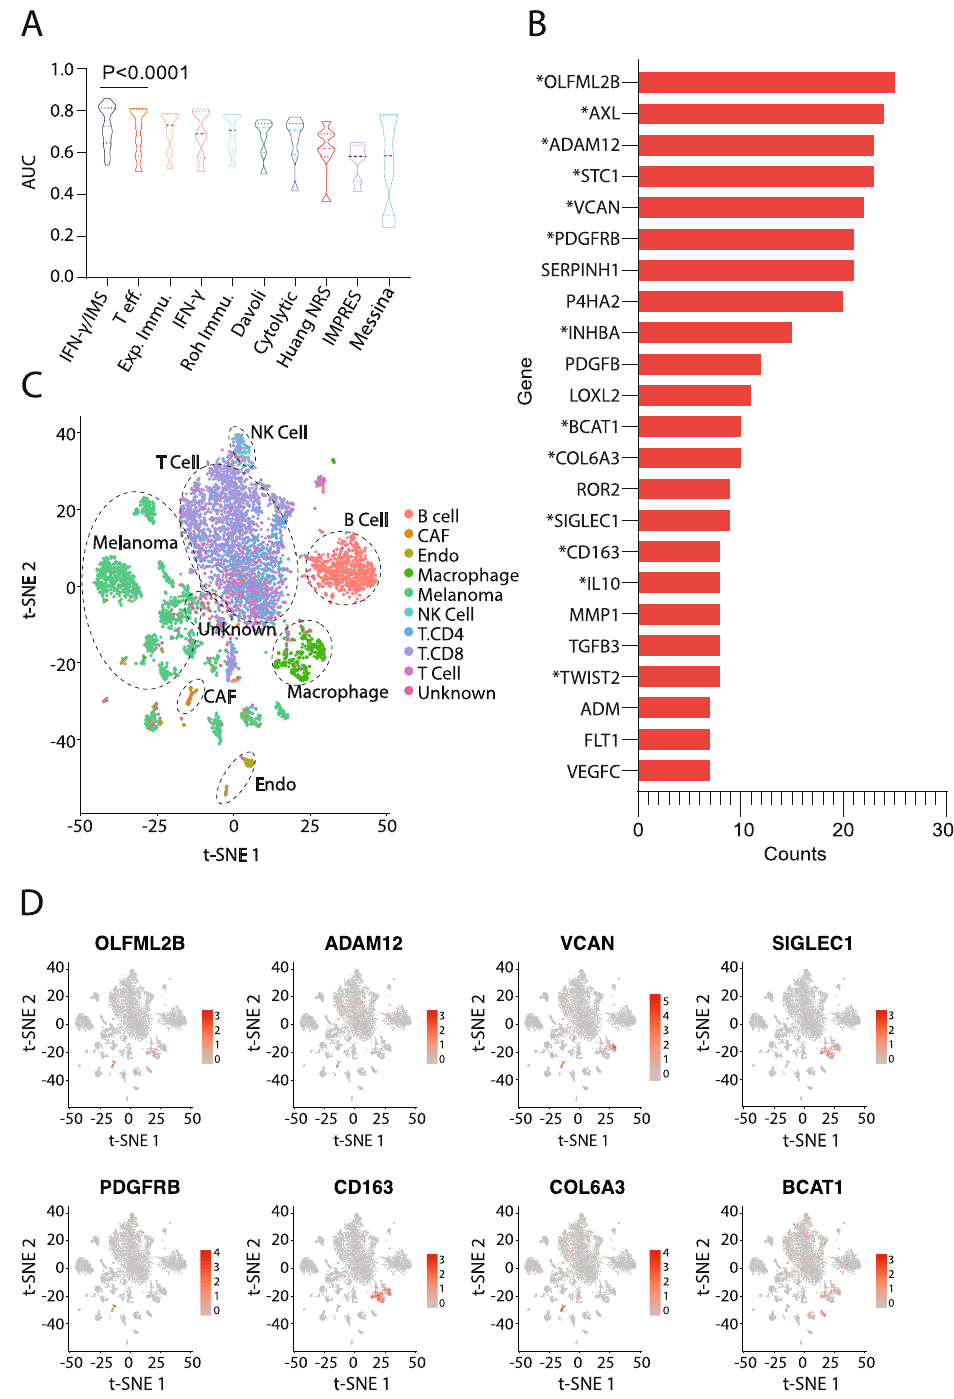
Fig. 7 Robustness of the proposed IMS signatures. A Comparison of AUC performance of IFN- γ /IMS ratio with nine published GEP signatures (Table 1) after 35 bootstrapping randomized tests on the seven datasets (Table 2). In each randomized test, the IMS genes were identi fi ed from three randomly selected datasets (see “ Methods ” section), and the AUC prediction performance of the ratio of IFN- γ signature and the IMS identi fi ed from the randomly selected dataset was evaluated on the remaining four datasets. Models are sorted by their median AUC performances and Wilcoxon matched-pairs signed rank test was performed to compare the AUC performances of IFN- γ / IMS and the second best model T eff. B Top 23 highly frequent genes from the bootstrapping tests. Genes in the original IMS signature are marked with an asterisk (*) symbol. C – D t-SNE plot of cells from melanoma 42 . Cells are colored by cell types in C and by normalized expression of different IMS genes in D